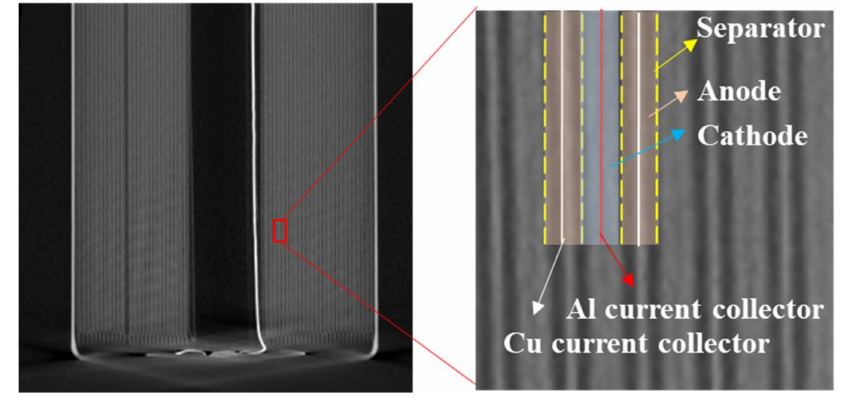
Figure 7. CT image of the cross-section of the electrode layers for a lithium-ion battery.